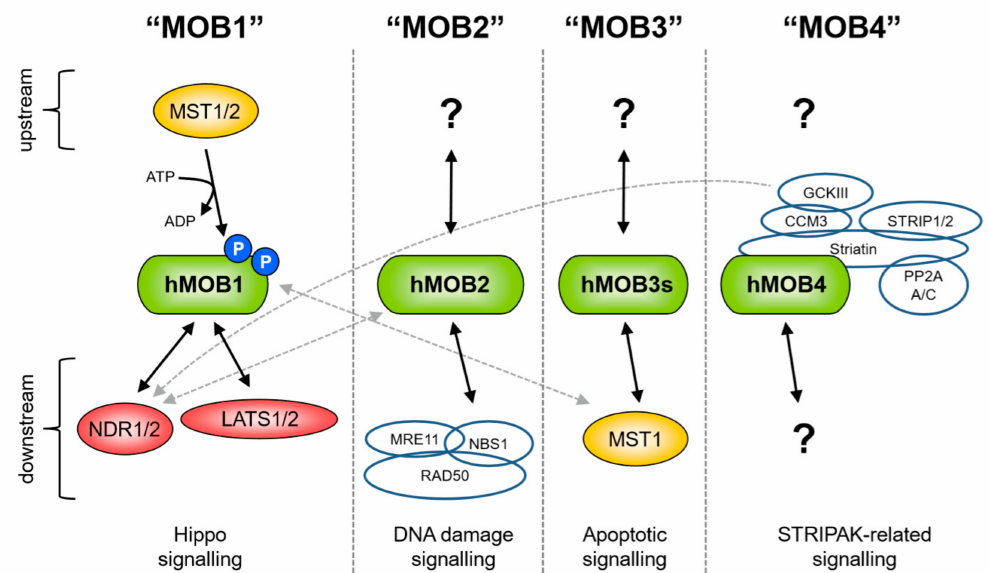
Figure 4. The four branches of MOB control. The “MOB1 branch”: In human cells, hMOB1 phosphorylated by MST1 / 2 promotes the activation of NDR1 / 2 and LATS1 / 2 in the context of Hippo signalling and the regulation of other important cellular functions [1,55,57]. The “MOB2 branch”: hMOB2 can interact with the MRN (Mre11-Rad50-Nbs1) DNA damage sensor complex, thereby supporting DNA damage and consequently cell cycle signalling [37,38]. The “MOB3 branch”: hMOB3s form a complex with MST1, in so doing regulating apoptotic signalling [39]. The “MOB4 branch”: hMOB4 as part of the STRIPAK (Striatin-interacting phosphatase and kinase) complex is likely to support the diverse cellular roles of the STRIPAK complex [43,44]. Notably, it is possible that these MOB branches do not signal in isolation, but rather may be interlinked as highlighted by dashed grey lines. For example, hMOB2 may connect with the “MOB1 branch” by competing with hMOB1 for NDR1 / 2 binding [35,62], the hMOB3s may link with the “MOB1 branch” through competing with hMOB1 for MST1 / 2 binding [6,39], or hMOB4 as part of the GCKIII-containing STRIPAK complex may connect with the “MOB1 branch” through GCKIII-mediated phosphorylation of NDR1 / 2 (see subchapter 4). Noteworthy, Hippo and STRIPAK signalling have already been found to be interconnected (see subchapter 4), although, to our knowledge, the specific roles of hMOB4 have not been defined. hMOBs are in green. MST1 / 2 and NDR / LATS kinases are in yellow and red, respectively. Established interactions are highlighted by black lines, while putative interconnections between “MOB branches” are shown by dashed grey lines. Phosphorylations are indicated by “P” in